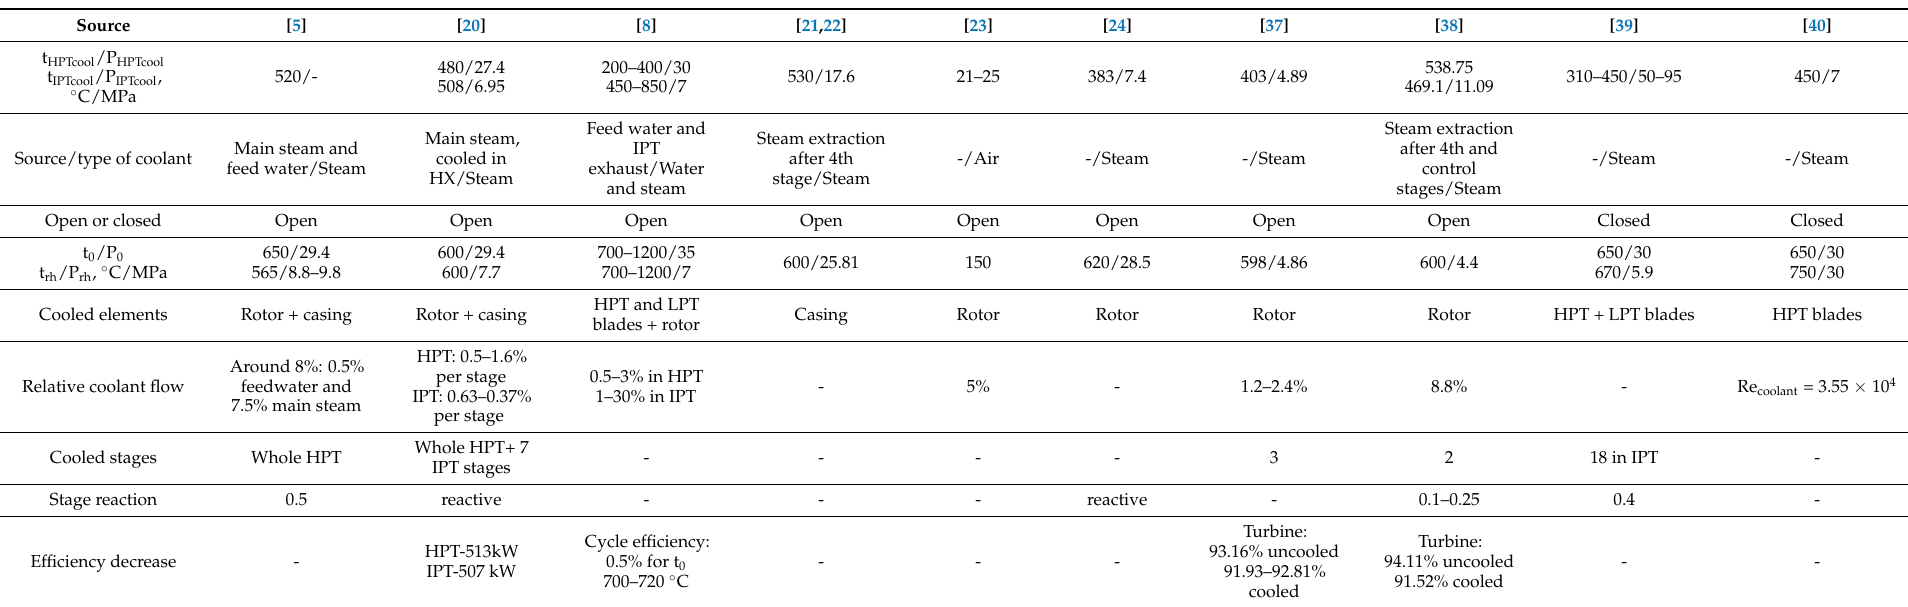
Table 3. Characteristics of existing cooling